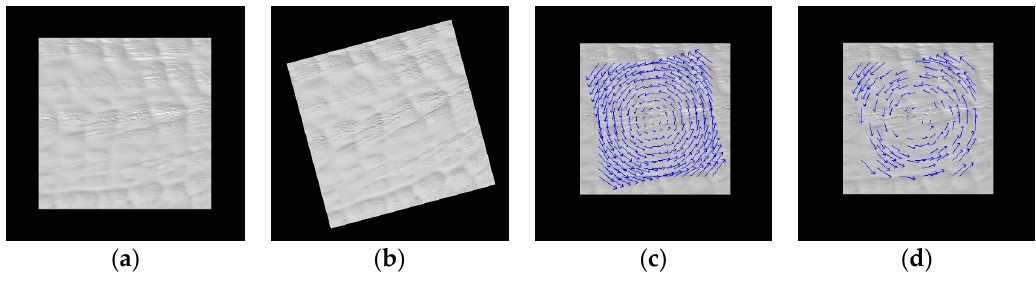
Figure 6. Ice velocity validation based on the simulated image. ( a ) Simulated master image; ( b ) Simulated slave image after 15° manual contrarotation based on the master image; ( c ) True vector displacement map; ( d ) Vector displacement derived using the rotation-invariant feature-tracking method.